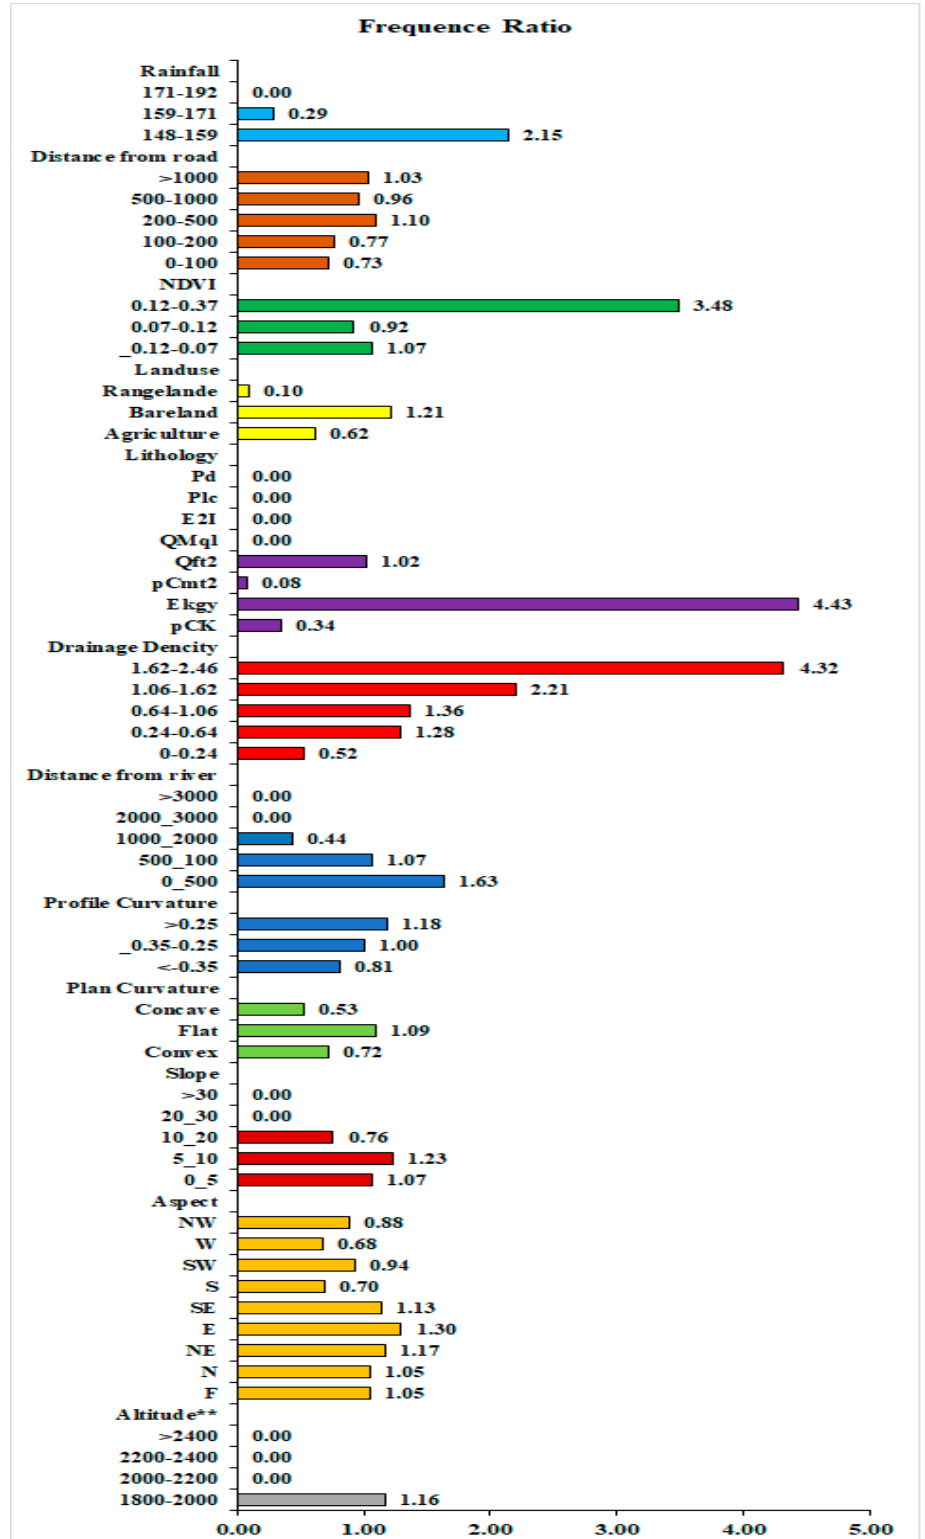
Figure 5. Frequency ratios for factors related to gully erosion.